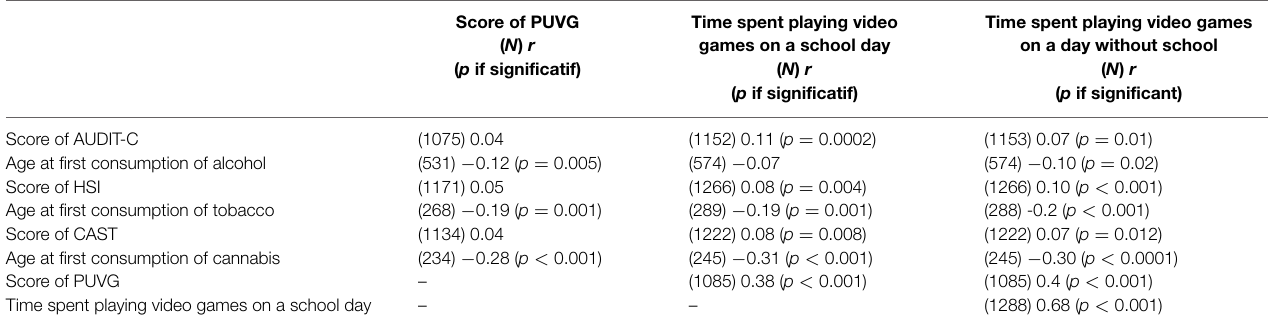
TABLE 3 | Pearson’s correlations between PUVG score, time spent playing video games, score of AUDIT-C, HSI, CAST and age at first substance